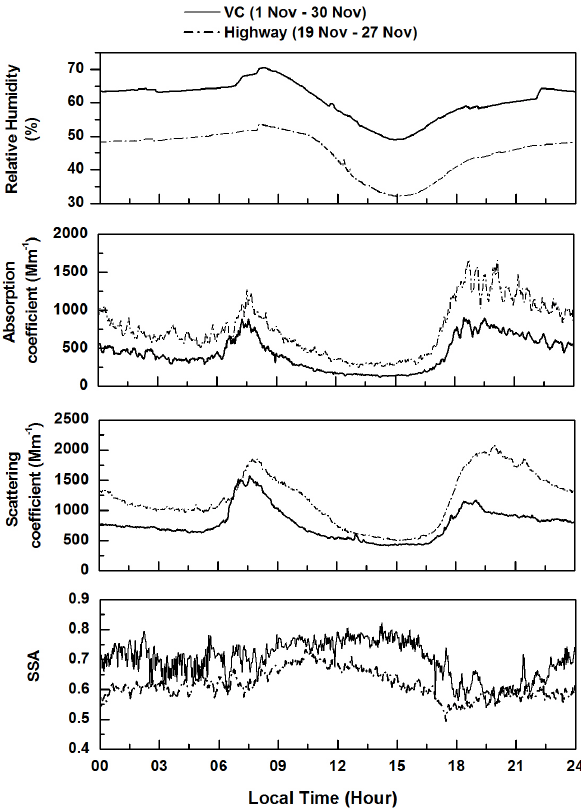
Fig. 8. Comparison of diurnal variation of relative humidity, absorp- tion coefficient, scattering coefficient and single scattering albedo (SSA) at SVI 1 village center (VC) and highway (traffic